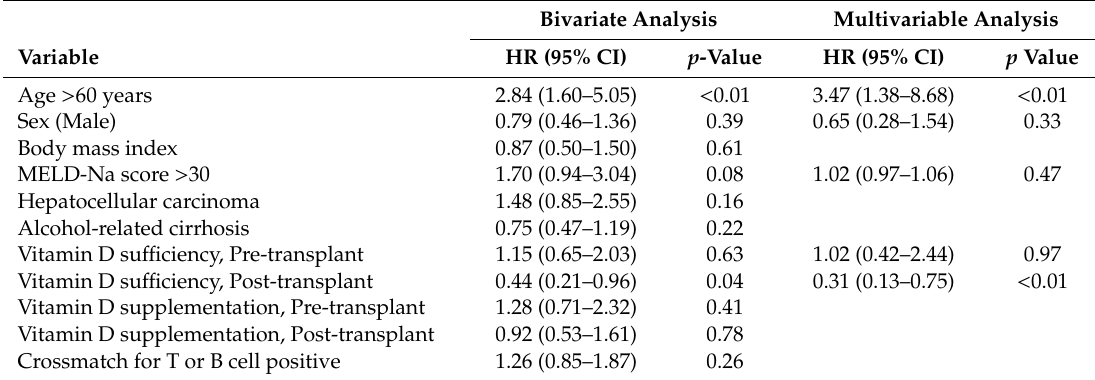
Table 3. Cox regression analysis of prognostic factors associated with overall survival.